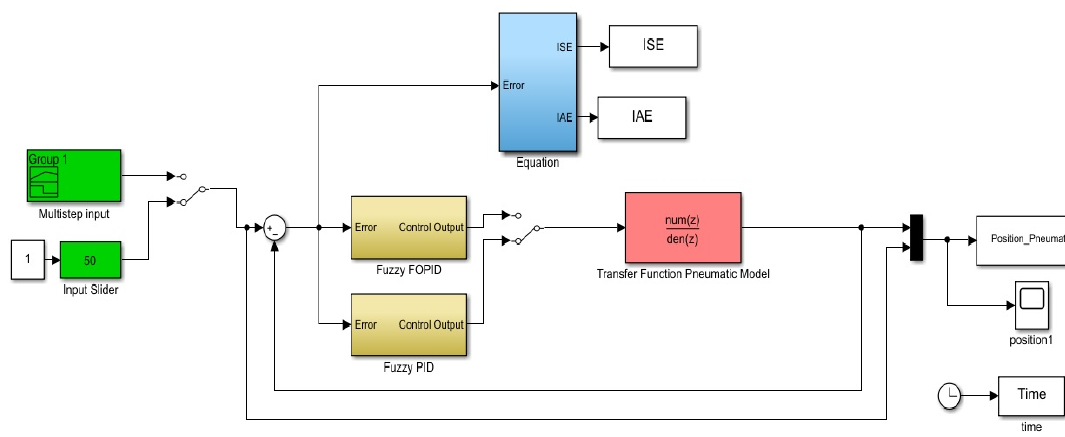
Figure 11. Simulink diagram for simulation.